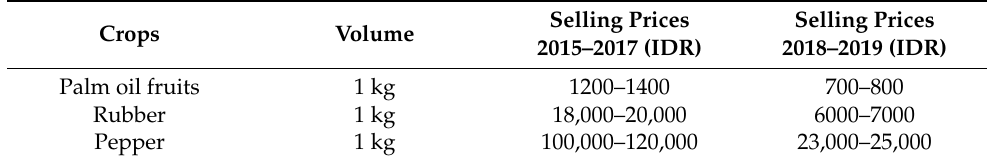
Table 9. Selling prices of cash crops.